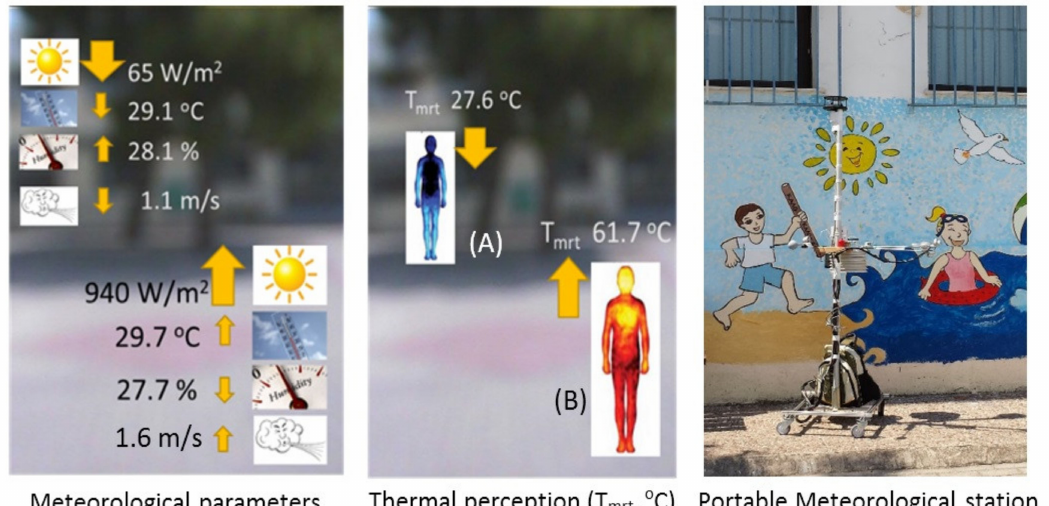
Figure 2. Spatial distribution of microclimatic parameters (measured by a portable meteorological station) and human thermal perception expressed in T mrt (calculated by Rayman model) under the shade of a cluster of 2 Pinus trees ( A ) and a nearby position exposed to intense incident solar radiation ( B ). Source [118].